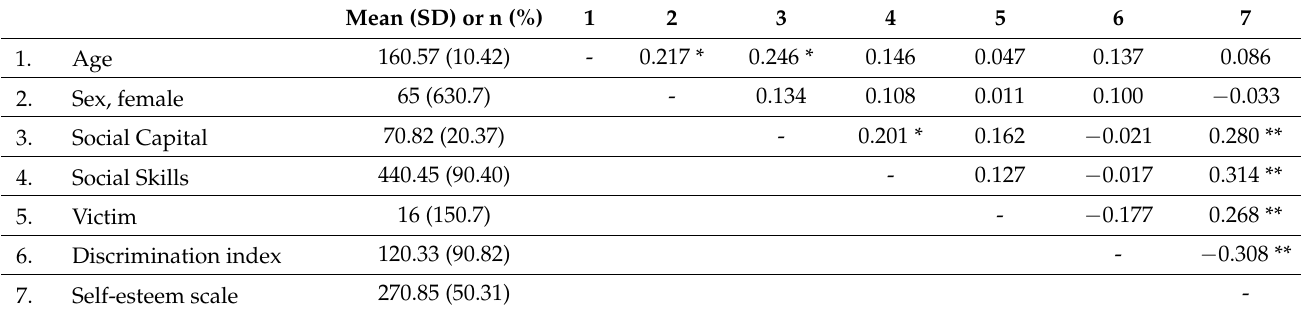
Table 3. Zero order correlations between variables.